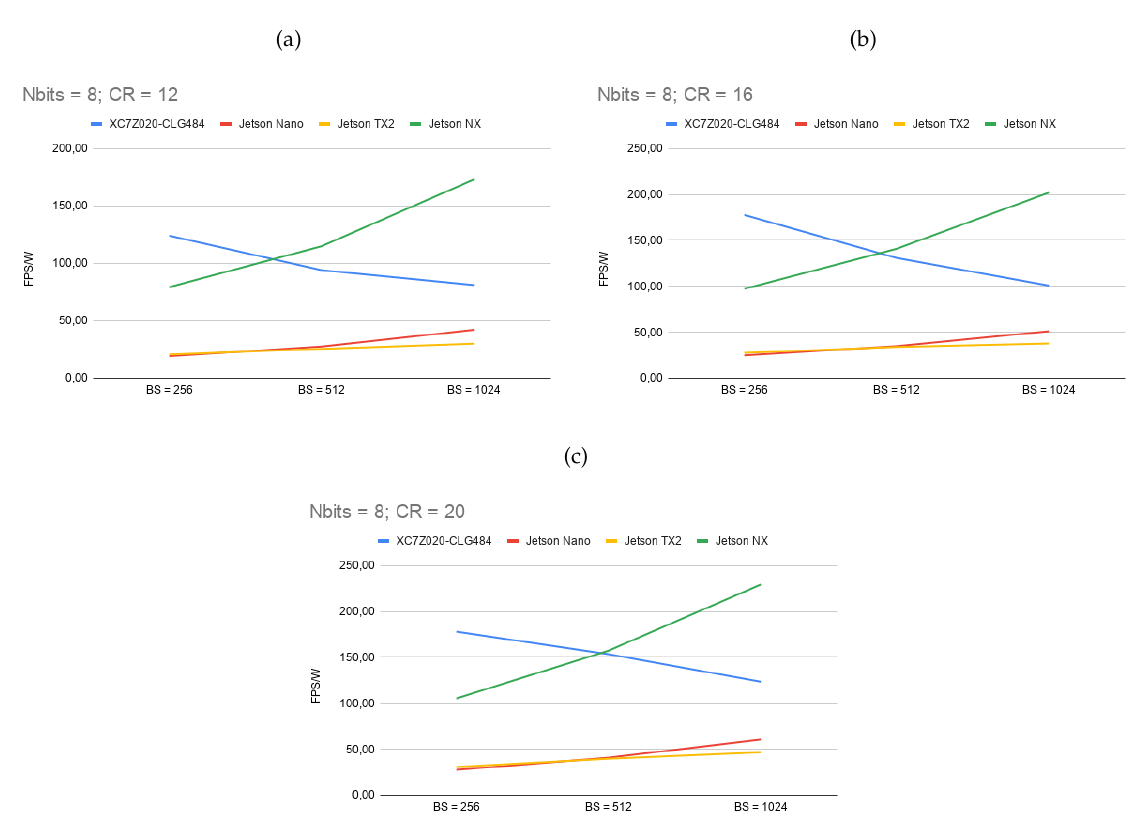
Figure 14. Comparison of the energy efficiency in the compression process, in terms of the ratio between obtained FPS and power consumption and the input parameter BS , reached by a Xilinx Zynq-7020 programmable SoC following the design-flow proposed in this work versus the GPU-based implementation model described in [29] performed onto some NVIDIA power-efficient embedded computing devices, such as Jetson Nano, Jetson TX2 and Jetson Xavier NX. ( a ) FPS N bits = 12, CR = 12; ( b ) FPS N bits = 12, CR = 16; ( c ) FPS N bits = 12, CR =